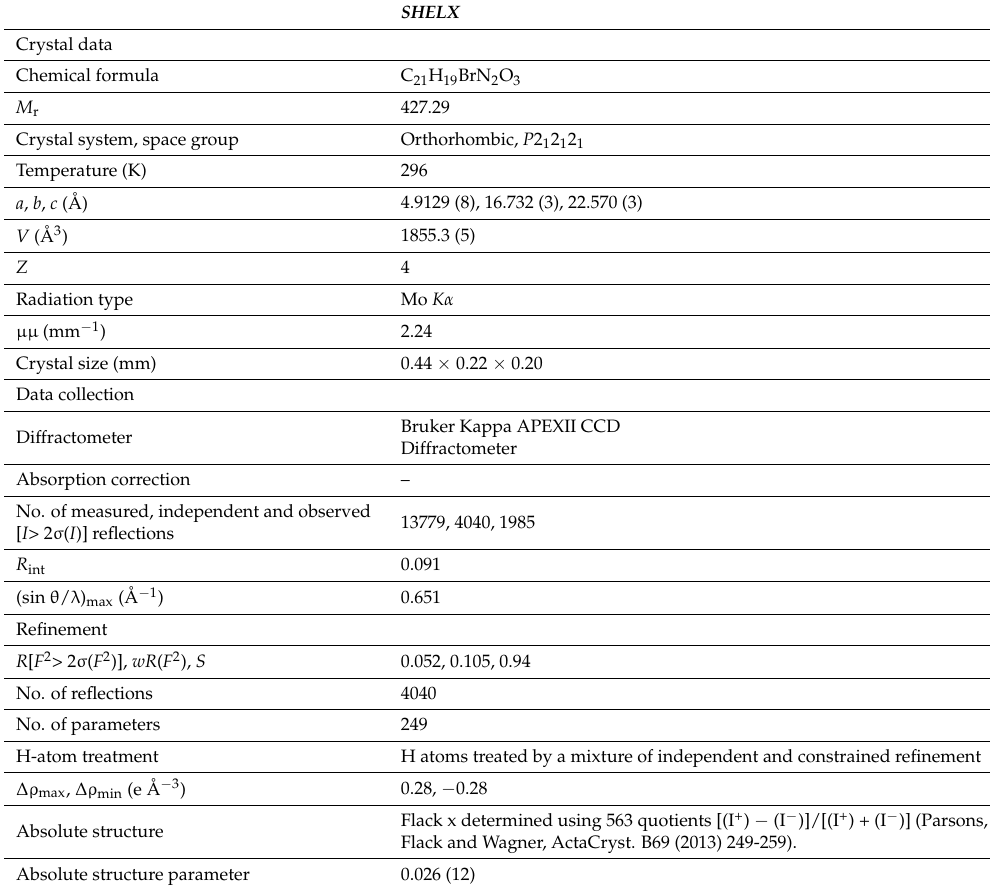
Figure 2. The packing diagram of the Schiff base ( 5 ) showing the infinite one-dimensional chains along the a-axis.